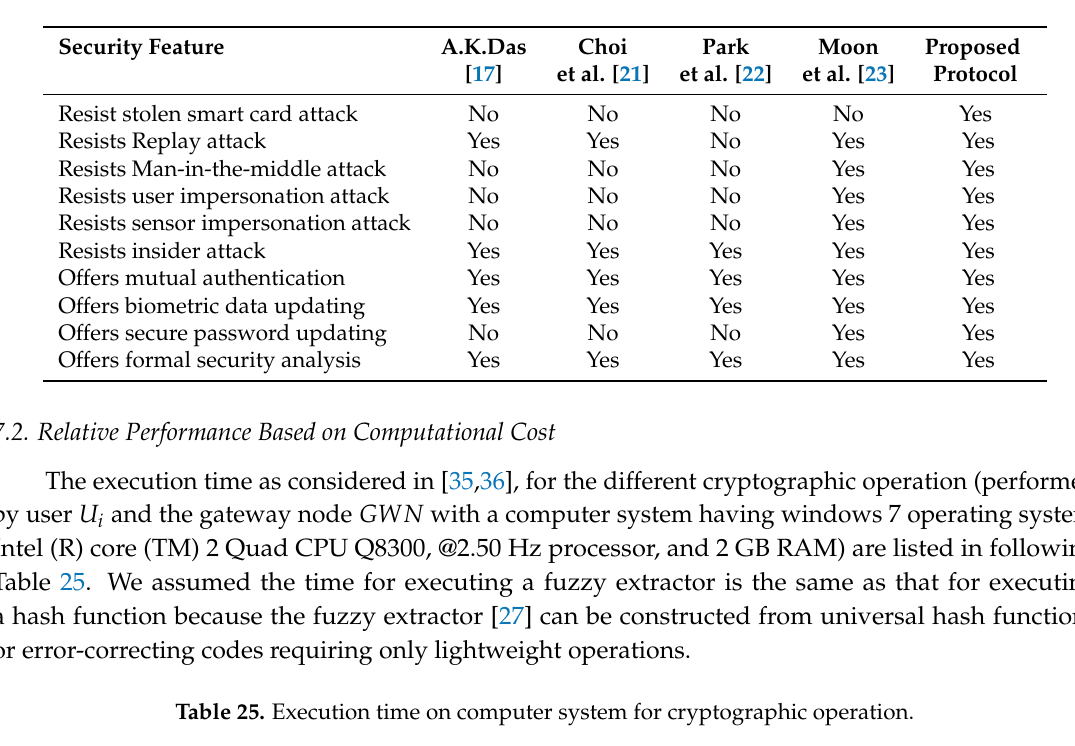
Table 24. Comparison of protocols based on security features.